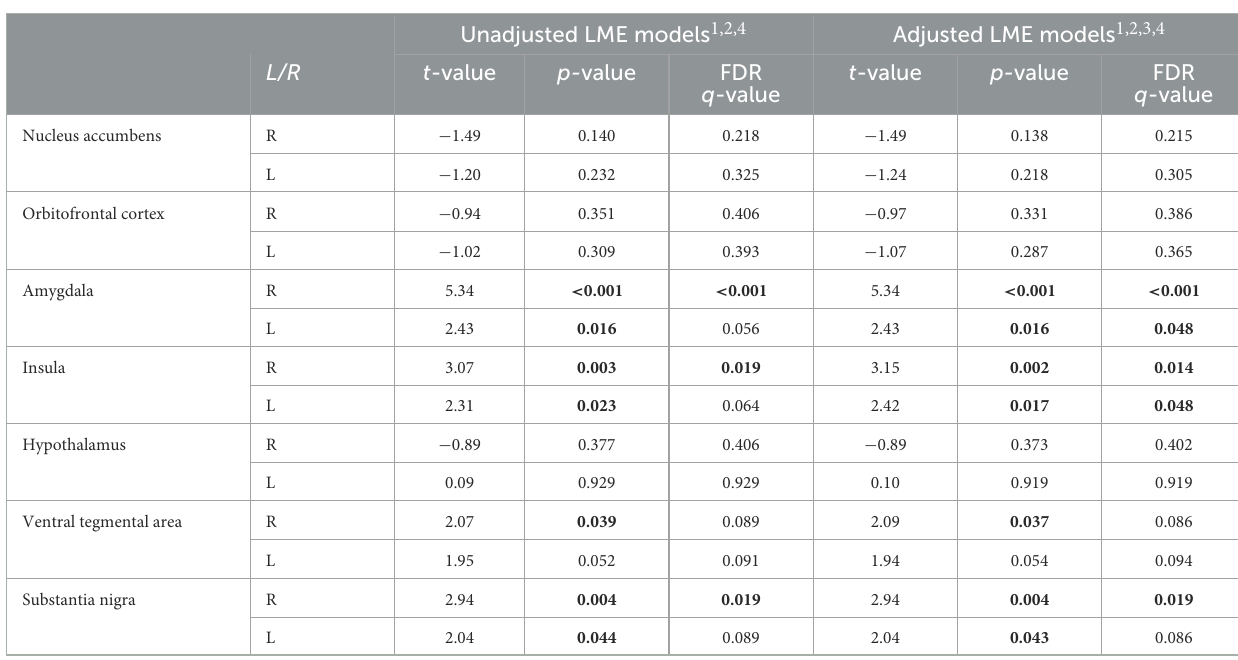
The corrected Table 2: TABLE 2 Region-of-interest (ROI) analysis ( N =